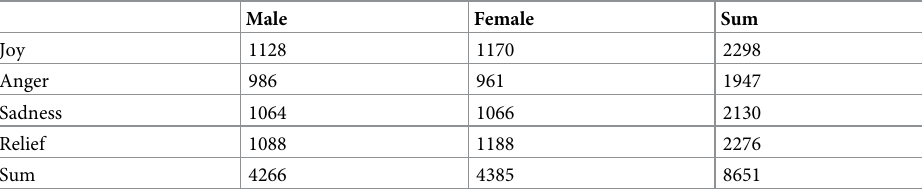
Table 3. Number of subjects for the experiment (short-term emotion).